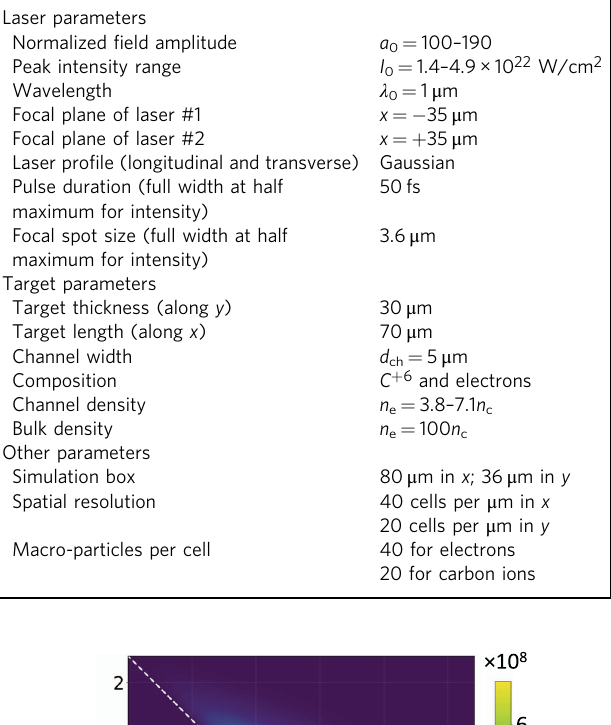
Table 1 2D PIC simulation parameters.